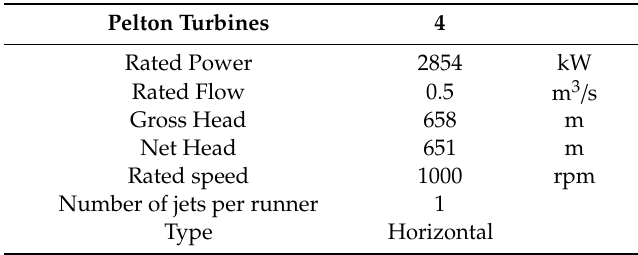
Table A2. Pelton turbines ratings.